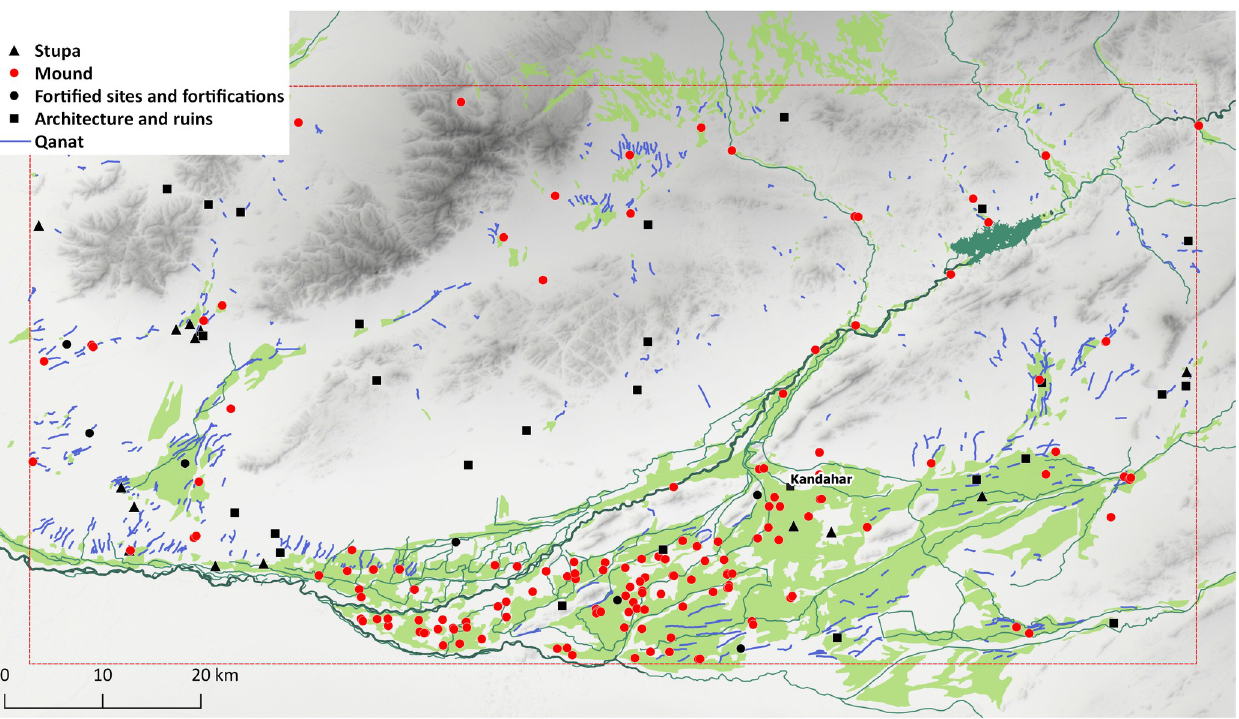
Fig 14. Map showing the distribution of all sites. DEM based on Shuttle Radar Topography Mission (SRTM) 1 Arc-Second Global courtesy of the U.S. Geological Survey (doi:10.5066/F7PR7TFT) (https://earthexplorer.usgs.gov). The map was created by the authors in QGIS.